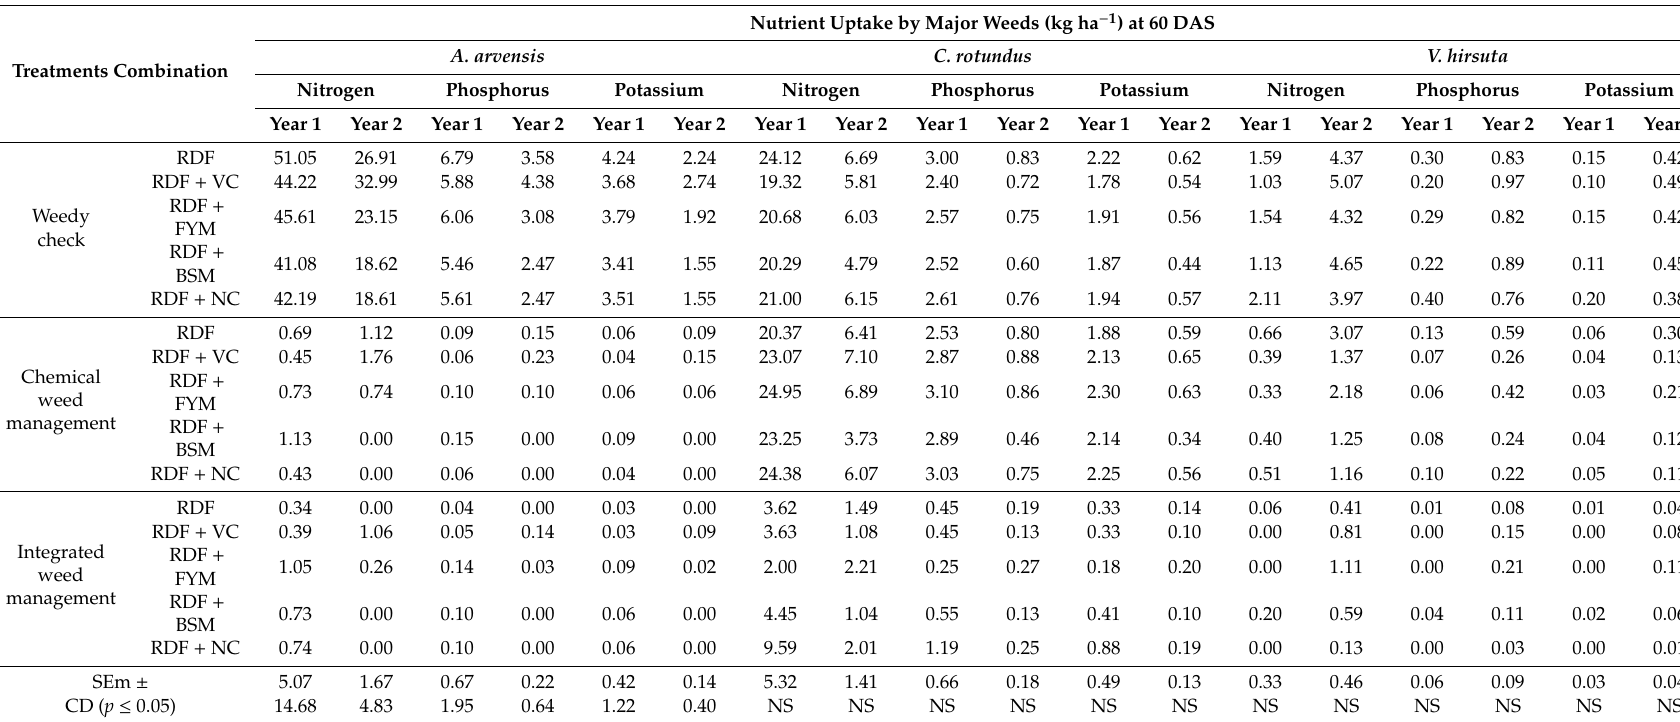
Table 4. Interaction e ff ect of di ff erent nutrient managements and weeding regimes on nutrient uptake (kg ha − 1 ) by Major Weeds at 60 DAS in Hybrid Maize.